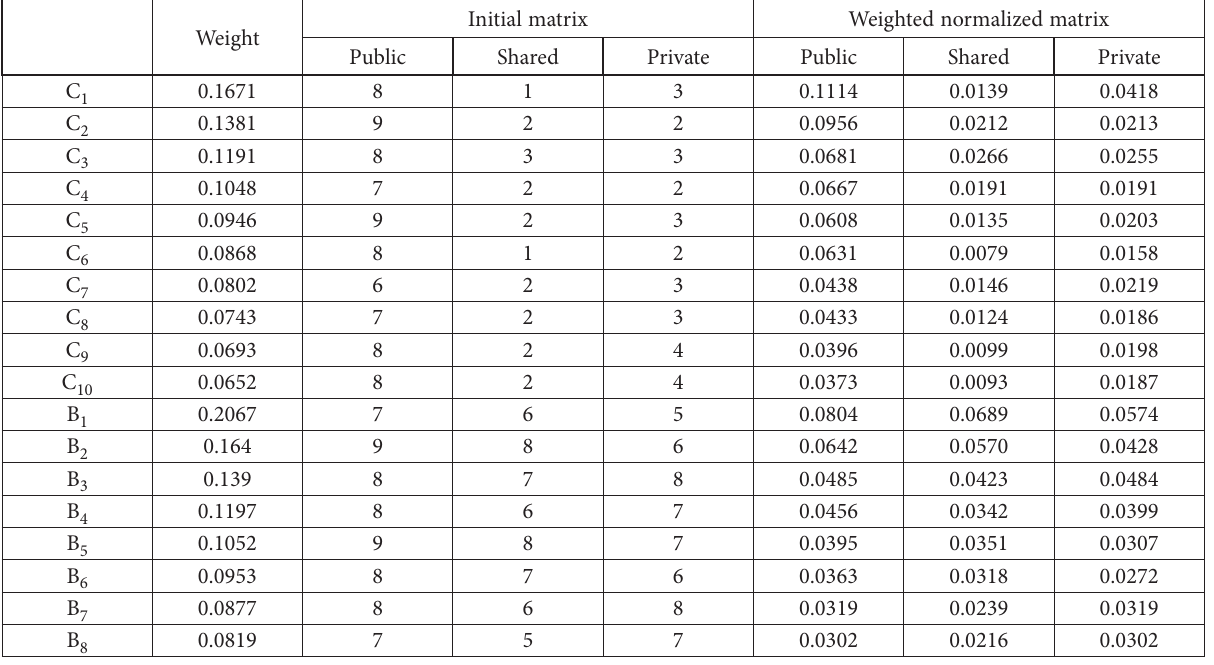
Table 8. Sample of initial and weighted normalised decision-making matrix